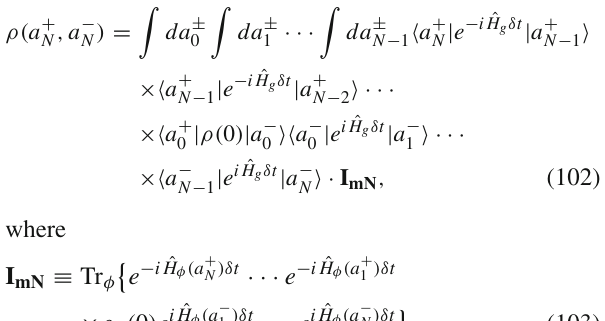
Fig. 19 Variations in the variance. The horizontal and vertical axes represent the time variable and variance, respectively. The parameters are taken as: α = 1, V 0 = π